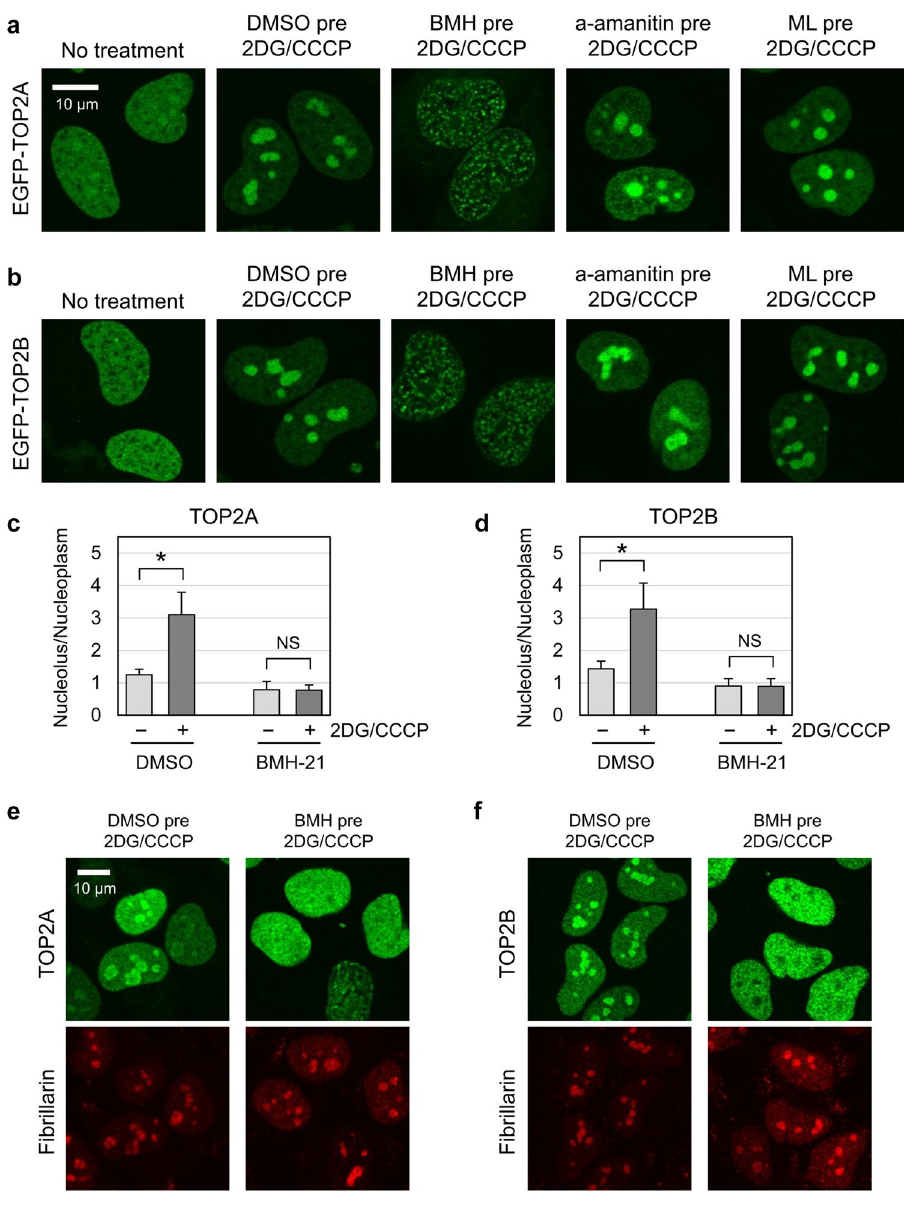
Figure 5. The RNA polymerase I inhibitor BMH-21 suppresses the nucleolar translocation of TOP2A and TOP2B in ATP-depleted cells. ( a, b ) Effects of RNA polymerase inhibitors on the nucleolar translocation of EGFP-TOP2A ( a ) and EGFP-TOP2B ( b ) in ATP-depleted cells. HeLa cells expressing EGFP-TOP2A or EGFP- TOP2B were pretreated with either DMSO (vehicle, 30 min), BMH-21 (1 µM, 30 min), α-amanitin (10 µg/ ml, 120 min), or ML-60218 (50 µM, 60 min). Cells were subsequently treated with 25 mM 2DG and 10 µM CCCP in the presence of respective RNA polymerase inhibitors for 15 min. ( c ) Nucleolus-to-nucleoplasm ratios of EGFP-TOP2A. Cells expressing EGFP-TOP2A were pretreated with either DMSO or 1 µM BMH-21 and subsequently treated with 2DG/CCCP as described in ( a ). Green fluorescence in the nucleolus and nucleoplasm was quantified, and average values of the nucleolus-to-nucleoplasm ratios and SD were calculated. (n = 30; *: statistically significant, p = 1.31E−15; NS: Not significant, p = 0.714). ( d ) Nucleolus-to-nucleoplasm ratios of EGFP-TOP2B. Experiments were performed on EGFP-TOP2B as described in ( c ). (n = 30; *: statistically significant, p = 7.82E−14; NS: Not significant, p = 0.973). ( e, f ) Immunofluorescence staining for endogenous TOP2A ( e ) and TOP2B ( f ). HeLa cells were treated as described in ( a ) and subjected to immunostaining for either TOP2A or TOP2B. Fibrillarin was coimmunostained to indicate the nucleoli